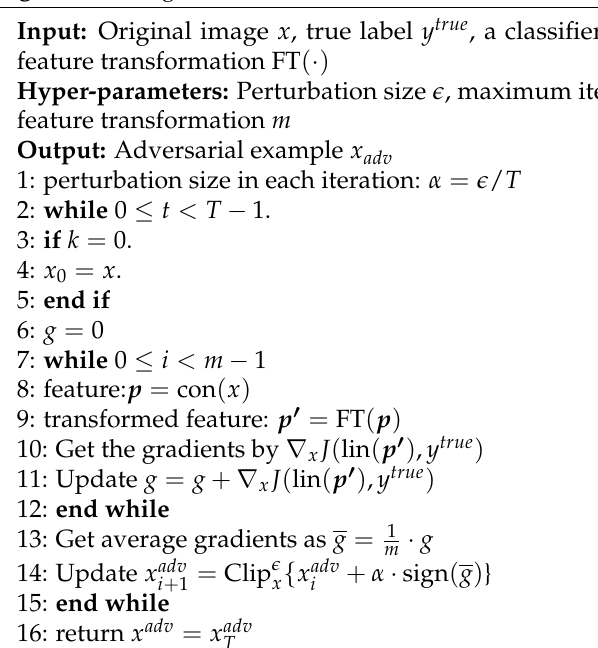
Algorithm 1 Algorithm of